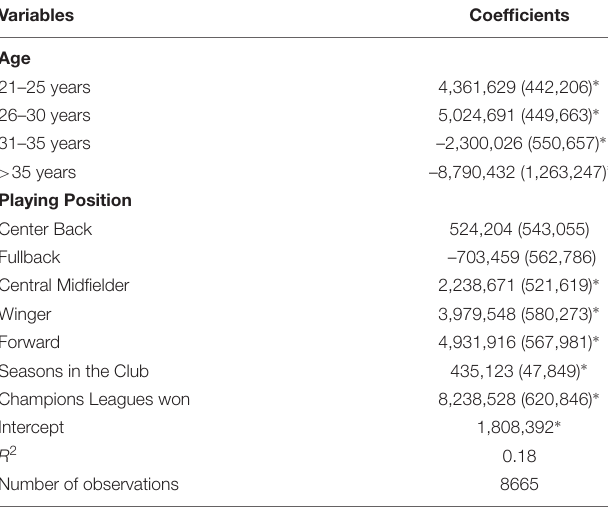
TABLE 1 | The influence of the age of the players, playing position, number of seasons in the club and number of Champions Leagues won on the market values of soccer